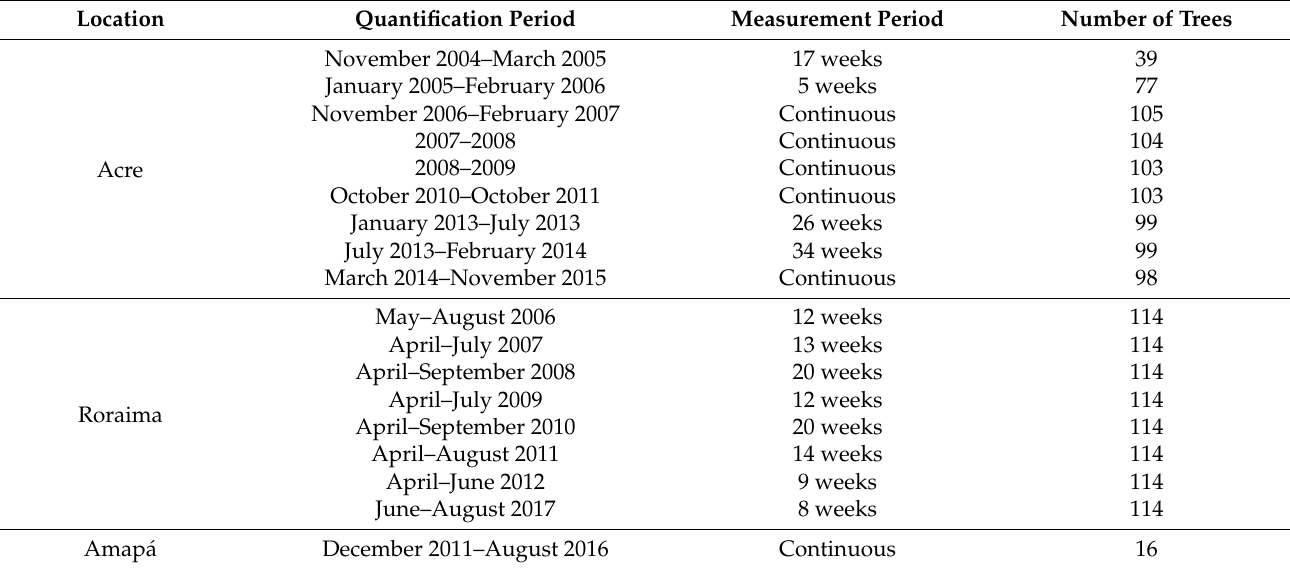
Table 1. The number of Carapa guianensis trees in Acre, Roraima, and Amap á , Brazil, monitored for annual estimates of seed production and the time period during which seed production was quantified for each region and the year of the study. Location Quantification Period Measurement Period Number of Trees